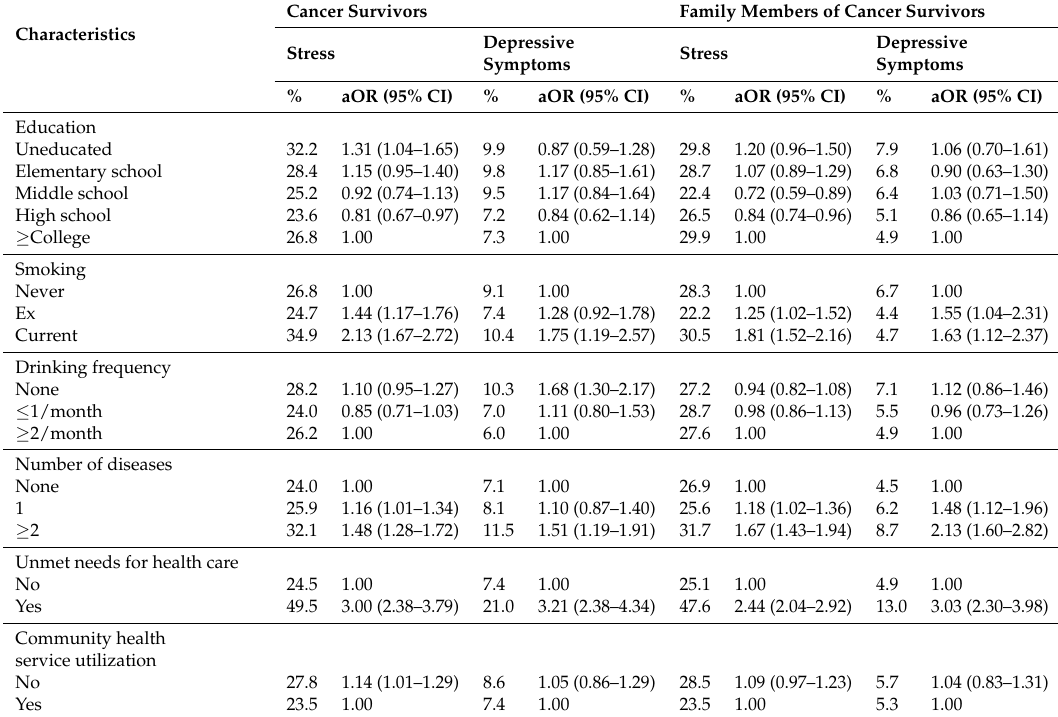
Table 3. Stress and depressive symptoms by characteristics in cancer survivors and family